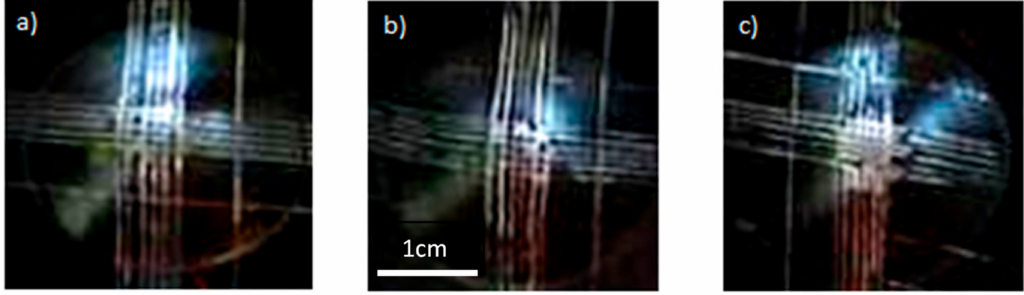
Figure 6. Shock test on ( a ) phosphated zinc + paint; ( b ) phosphated zinc + TEOS/MAP + paint; and ( c ) phosphated zinc + GPTMS/ASB +